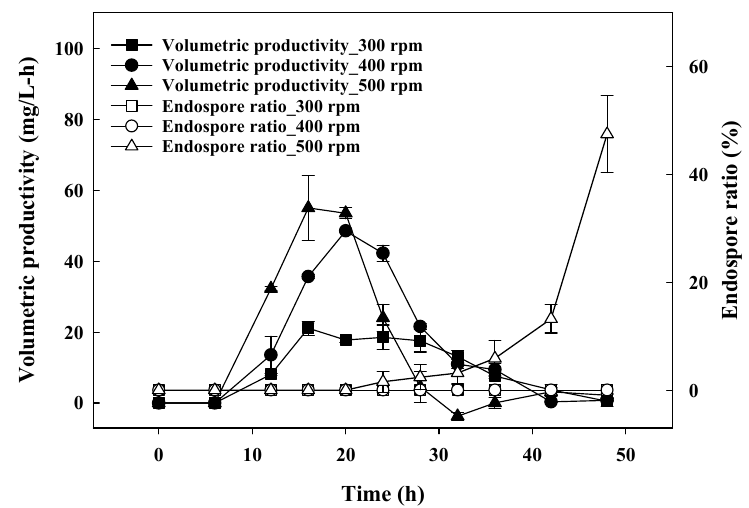
Figure 4. Profiles of volumetric surfactin productivity and spore ratio. Closed and open symbols indicate volumetric productivity and spore ratio, respectively. Cultivations were performed in 5 L jar bioreactors at 30 °C for 48 h.